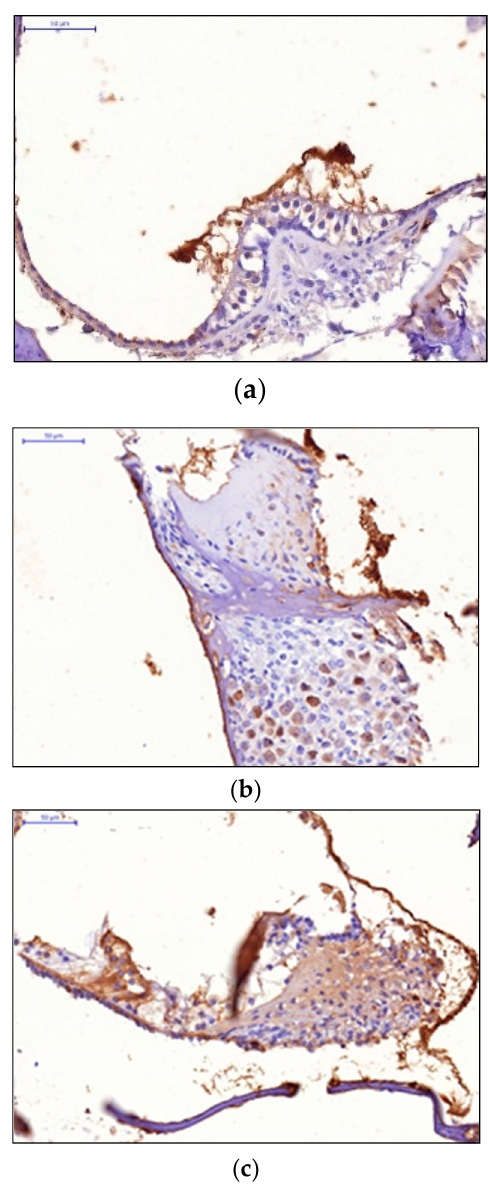
Figure 3. HIF-1 expression in the cells of the receptor apparatus and the cells of the spiral gan- glion: ( a ) Preventive dose 5 mg/kg; ( b ) Preventive dose 7 mg/kg; ( c ) Preventive dose 10 mg/kg.